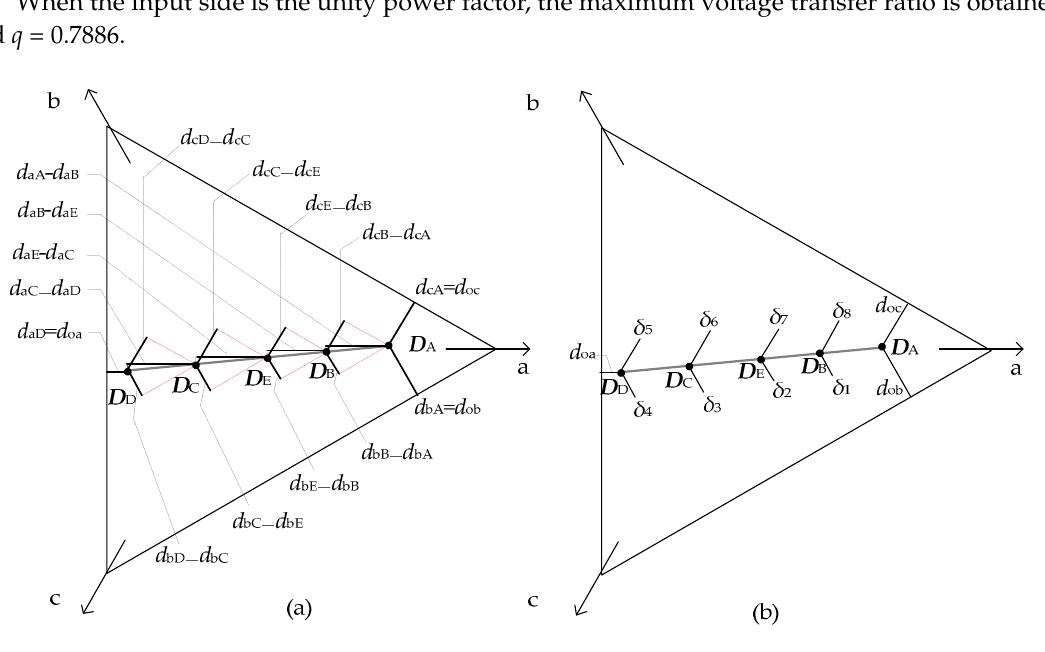
Figure 2. Decomposition and simplification of duty cycles of the three ‐ to ‐ five phase DMC: Figure 2. ( a ) decomposition of five duty ‐ cycle space vectors; ( b ) simplification of a decomposed duty cycle. ( a ) decomposition of five duty-cycle space vectors; ( b ) simplification of a decomposed duty